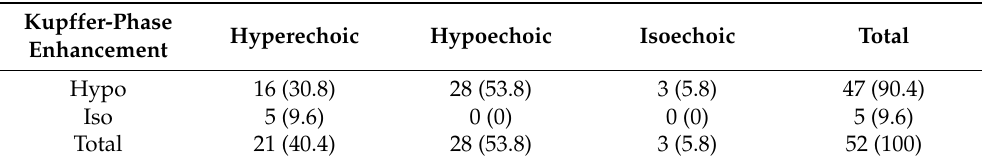
Figure 4. Images in 72-year-old woman with pathologically confirmed hepatocellular carcinoma in segment 8 of the liver. In B-mode US, a 5.5 cm hyperechoic nodule is observed ( a , arrows). In Sonazoid-enhanced US, the nodule shows arterial phase hyperenhancement ( b , arrows) and does not show washout until 5 min after contrast media injection ( c , arrows). The nodule shows isoenhancement in the Kupffer phase ( d , arrows). Table 6. Correlation between Kupffer-phase enhancement and grayscale echogenicity on hepatocellular carcinoma.